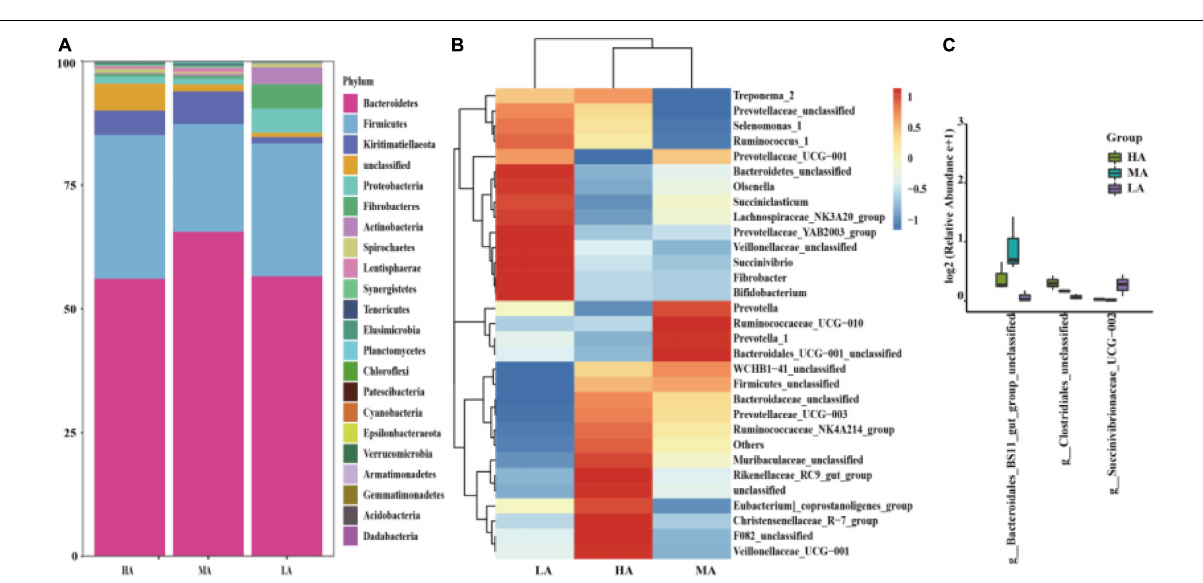
FIGURE 2 | Classification of the bacterial community composition. (A) Phylum level. (B) Genus level. (C) Extended error bar plot showing the bacteria at the genus level that had significant differences among the HA, MA, and LA groups. HA, high alfalfa percentages group; MA, middle alfalfa percentages group; LA, low alfalfa percentages